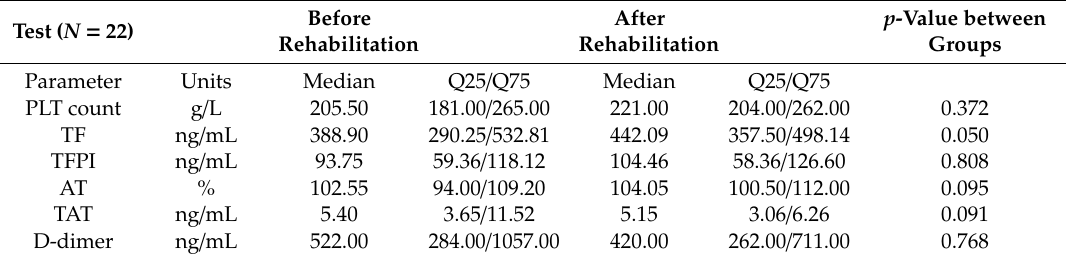
Table 6. Parameters of hemostasis before and after a four-week rehabilitation program in patients from group III (more than six months after